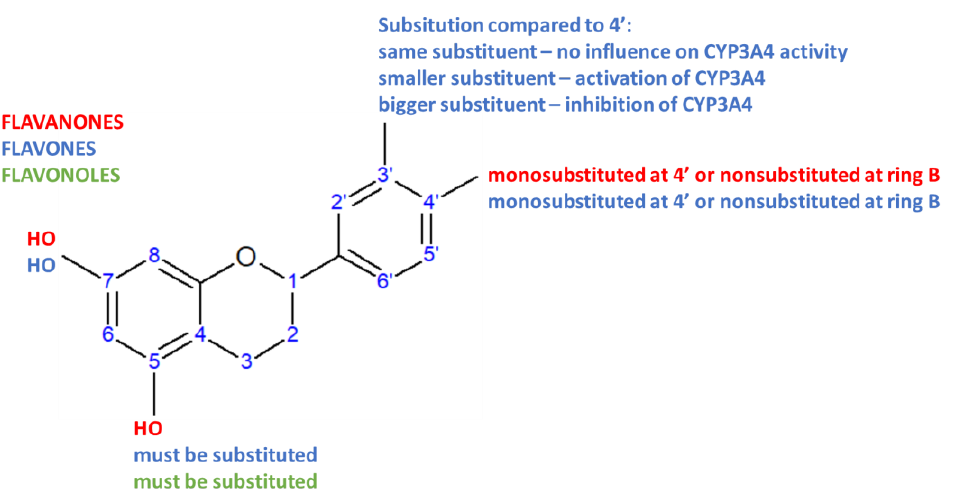
Figure 2. Contribution of structural features to the inhibitory effect (if not otherwise stated) of different classes of flavonoids on the activity of CYP3A4 enzyme. Each class is represented with a different color.